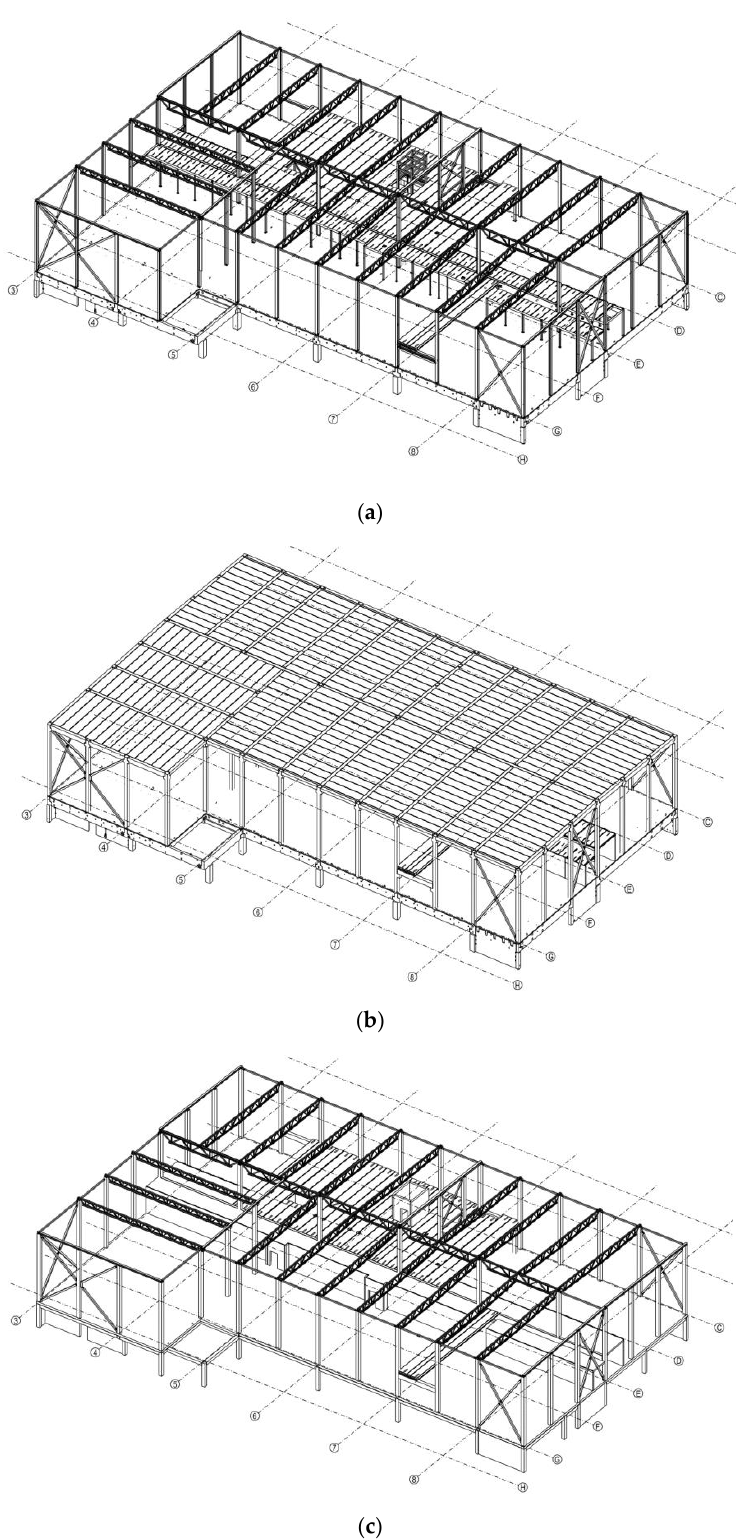
Figure 5. Alternative structural solutions of the building under investigation: ( a ) — alternative A1; ( b ) — alternative A2; ( c ) — alternative A3.